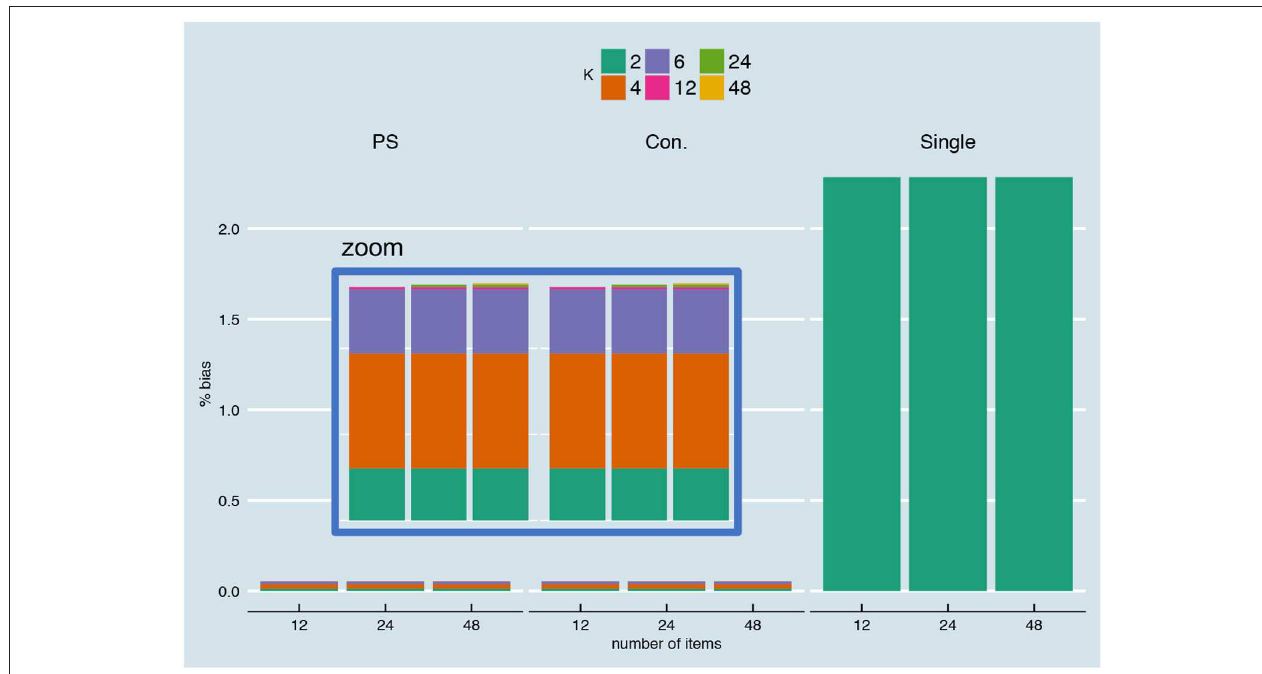
FIGURE 14 | Percentage bias (see Equation 25) for different number of items, for the relationship depicted in Figure 5A and with continuous parallel test